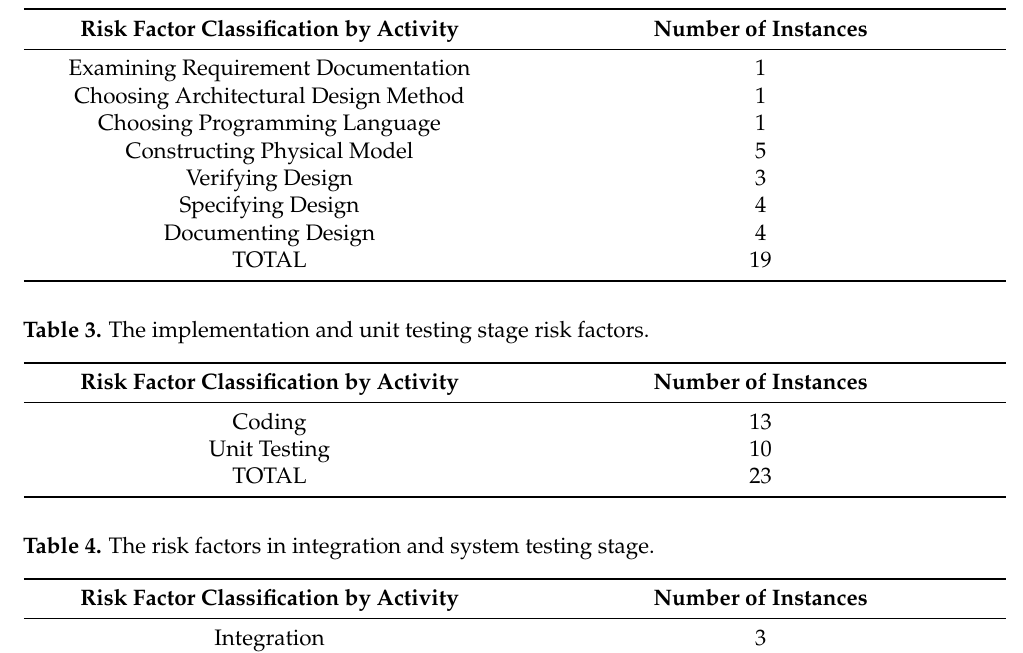
Table 2. The system design stage risk factors.